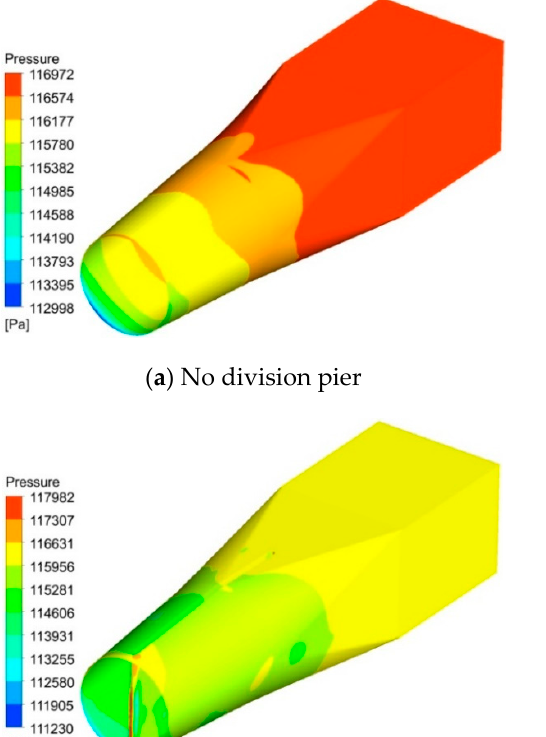
sure distribution. From scheme 1 to scheme 3, there was a small high-pressure area near the wall at the starting position of the division pier, which was due to the diversion ef- fect on the flow at the starting position of the division pier, resulting in the disorder of the local streamline; for the flow deviation, there may have been a small range of vorti- ces at the deviant position, resulting in the increase of the pressure near the wall at the starting position of the division pier. However, there was no high-pressure area in the round to square diffusion section and straight pipe section, according to Figure 12; the flow pattern here was good and the vortex could not easily create a high-pressure area. The results show that the pressure near the wall of the straight outlet conduit decreased as a whole and the stress condition of the straight outlet conduit improved, but the divi- sion pier with different lengths had no obvious effect on the pressure distribution near the wall of the straight outlet conduit.